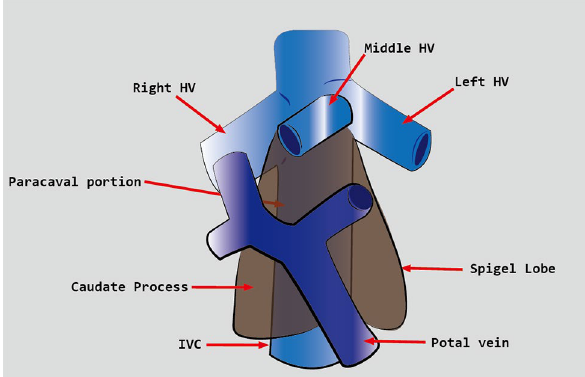
Figure 1. Anatomy of the caudate lobe. HV hepatic vein, PV portal vein, IVC inferior vena